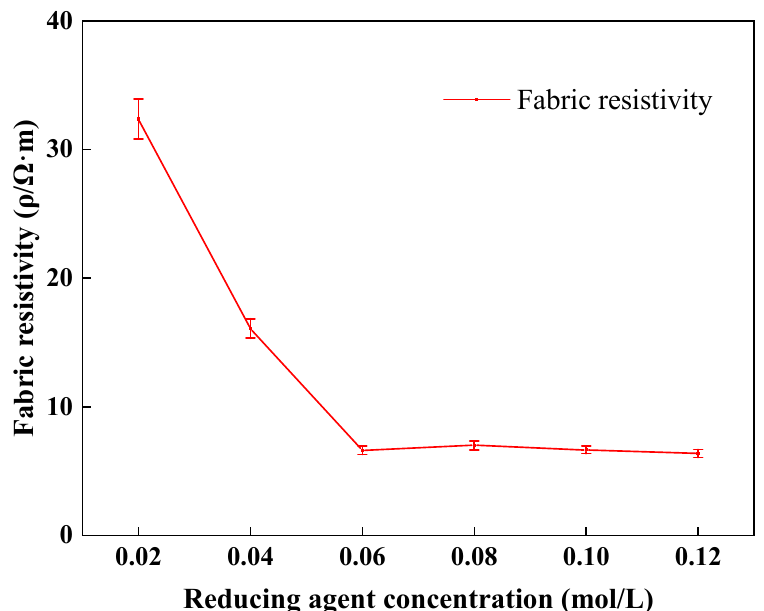
Figure 6. Fabric resistivity of the prepared samples with different reducing agent concentrations.